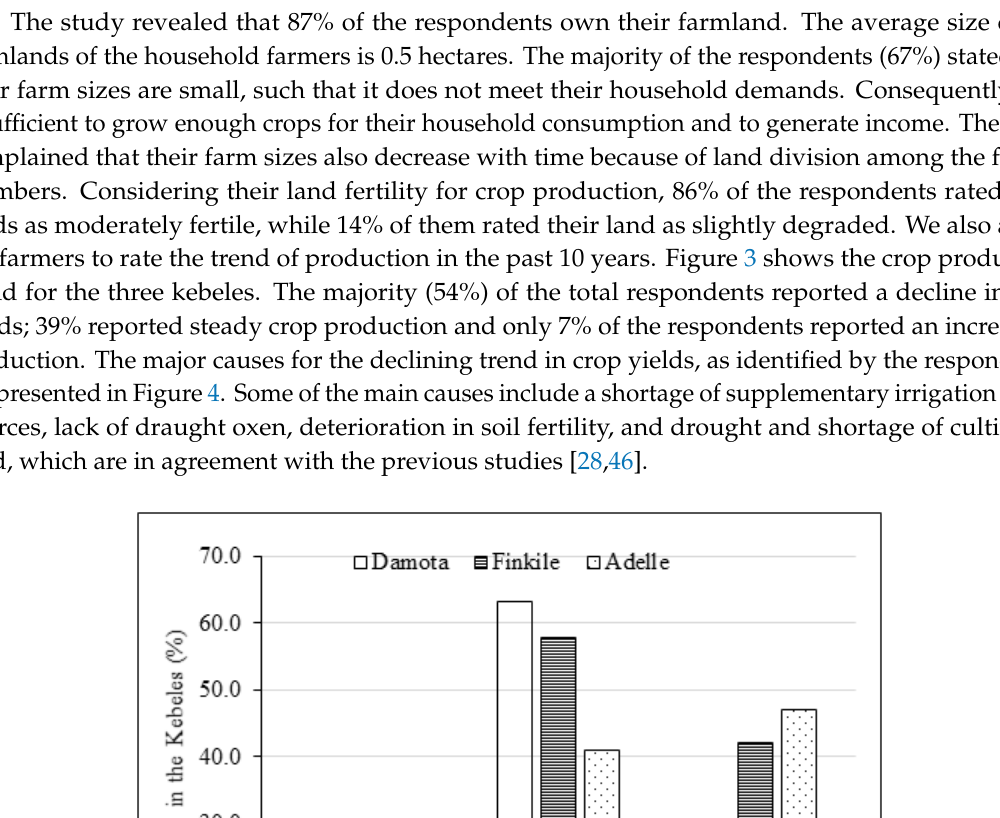
Figure 4. Causes of crop yields decline in the past 10 years of the three selected kebeles of the Haramaya District (Source: Elaborated by the Authors).